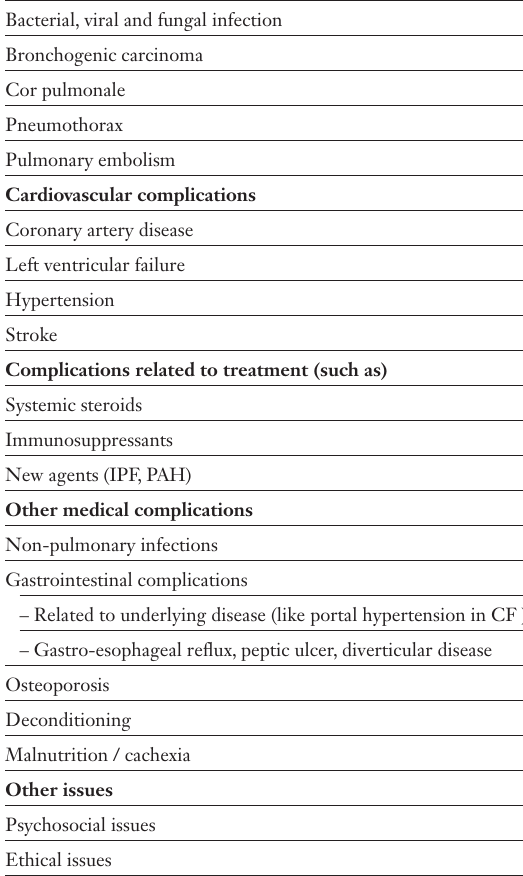
Co-morbidities in ad- vanced lung